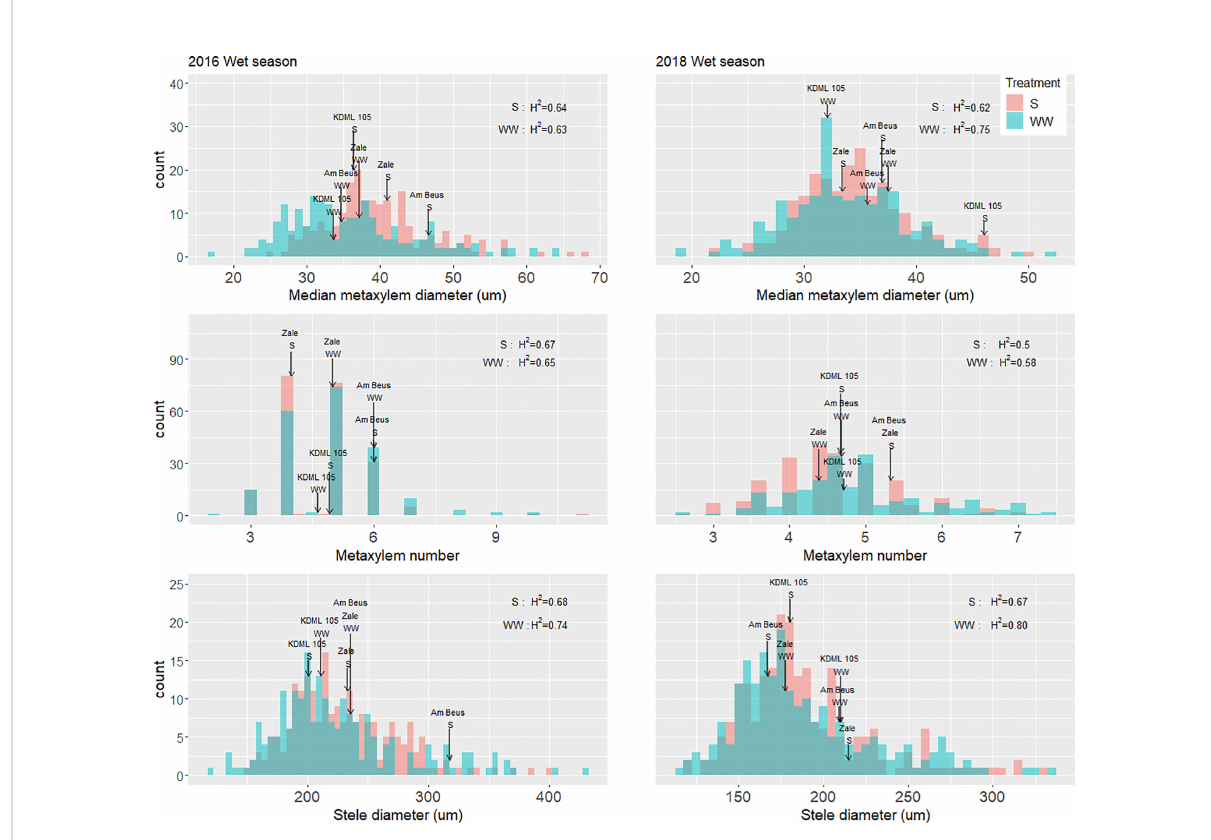
FIGURE 2 Distributions of root anatomical phenotypes in puddled, transplanted (2016WS, left) and direct seeded (2018WS; right) trials on the Thai/SE Asia panel characterized in this study. Arrows indicate the values for the check variety KDML 105 in each treatment, as well as for Am Beus and Zale which stood out in the accession rankings and AMMI analysis for grain yield (Figure S5). WS, wet season; S, drought stress treatment; WW, well- watered treatment; H 2 , broad-sense